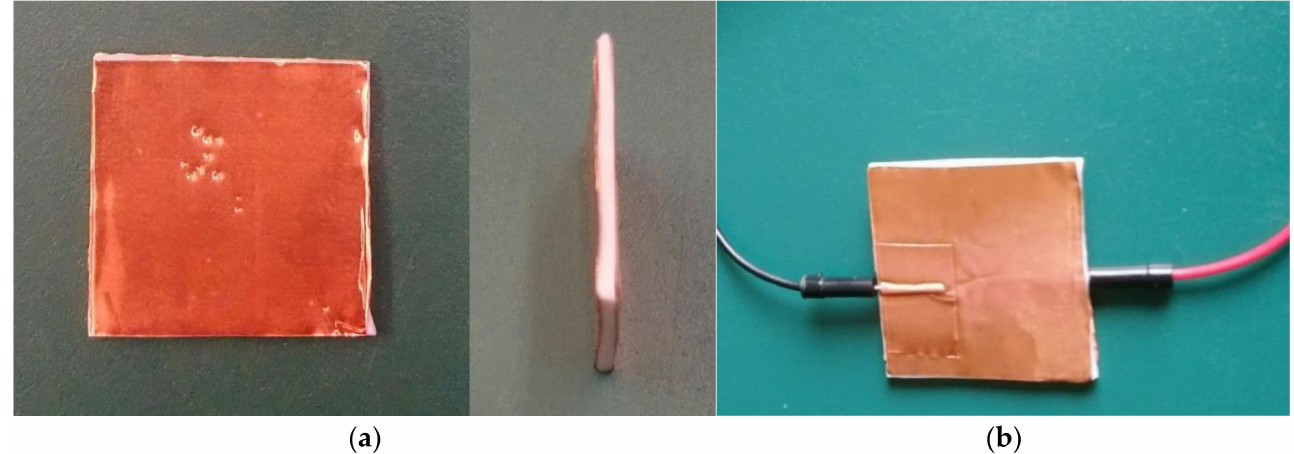
Figure 12. Capacitor with test sample: ( a ) front and side views; ( b ) copper foil sockets with contact